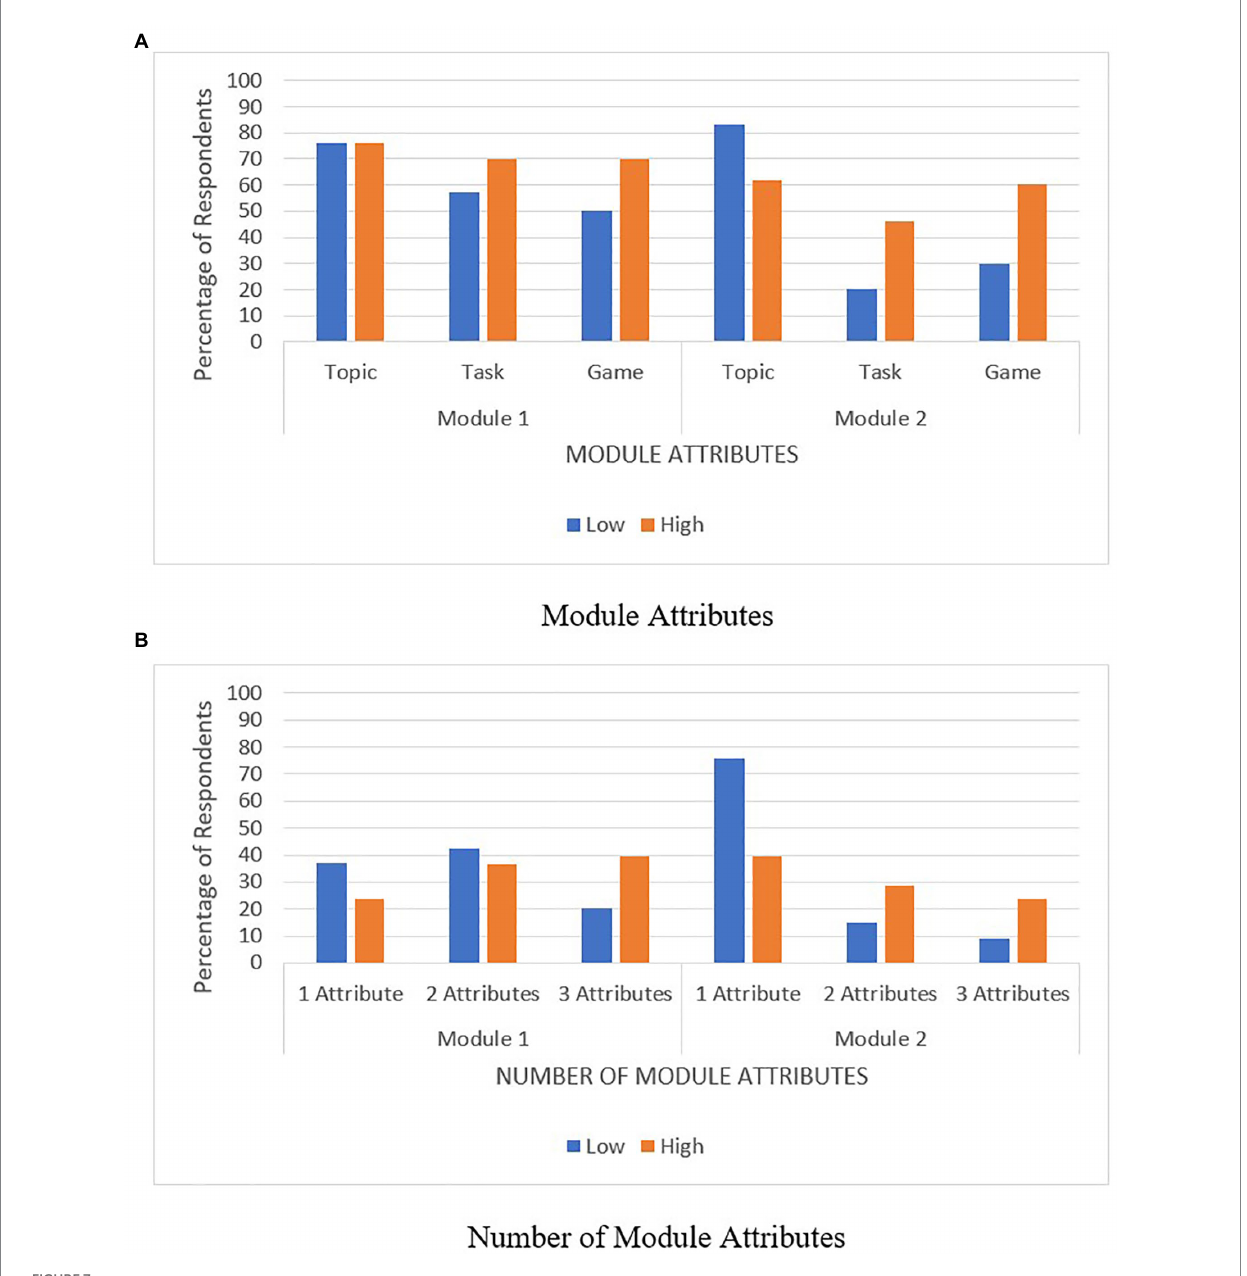
FIGURE 7 Responses on favorite module attributes, (A) Module attributes, (B) Number of module attributes.